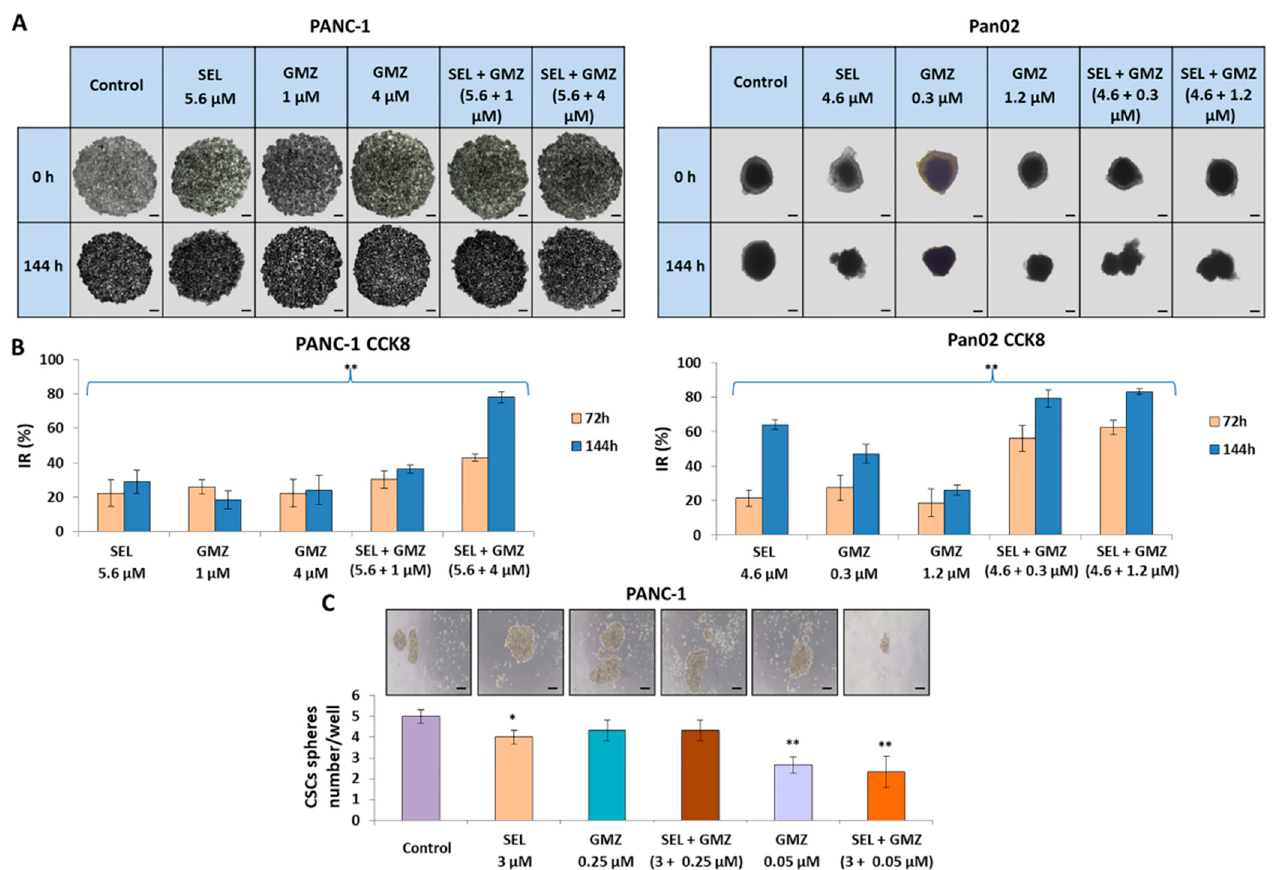
Figure 5. Cell growth inhibition of MTS from PANC-1 and Pan02 pancreatic cancer cell lines after selenite treatment. ( A ) PANC-1 and Pan02 MTS in culture with different treatments at 0 and 144 h. ( B ) CCK8 analysis on the PANC-1 and Pan02 MTS at 72 and 144 h. Data are presented as mean ± SD of octuplicate cultures. ** p < 0.01 vs. respective control group. ( C ) Study of CSC sphere formation. Data are presented as mean ± SD of three independent experiments; * p < 0.05 and ** p < 0.01 vs. respective control group. GMZ (gemcitabine); SEL (sodium selenite).